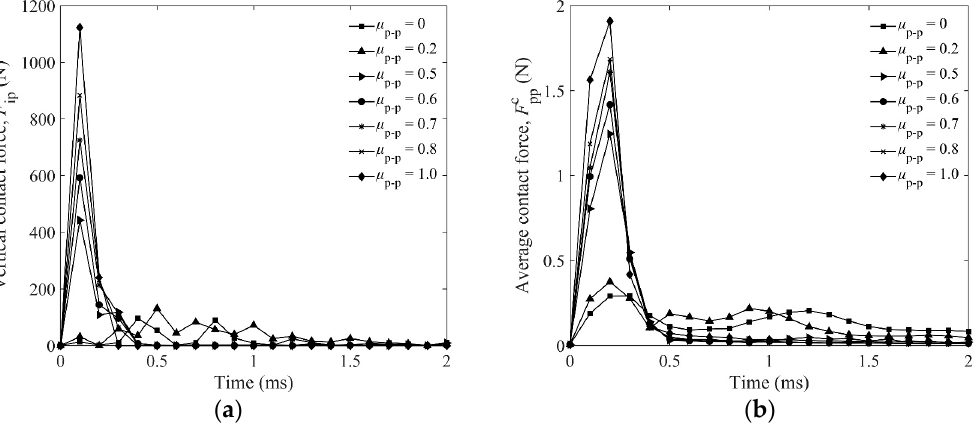
Figure 17. ( a ) 𝐹 (cid:2919)(cid:2926)(cid:2913) as a function of time, 𝐹 (cid:2919)(cid:2926)(cid:2913) is the vertical contact force between impactor and par- Figure 17. ( a ) F c as a function of time, F c is the vertical contact force between impactor and particles; ip ip ticles; and ( b ) 𝐹 (cid:2926)(cid:2926)(cid:2913) as a function of time, 𝐹 (cid:2926)(cid:2926)(cid:2913) is the average contact force between all particles. and ( b ) F c pp as a function of time, F c pp is the average contact force between all